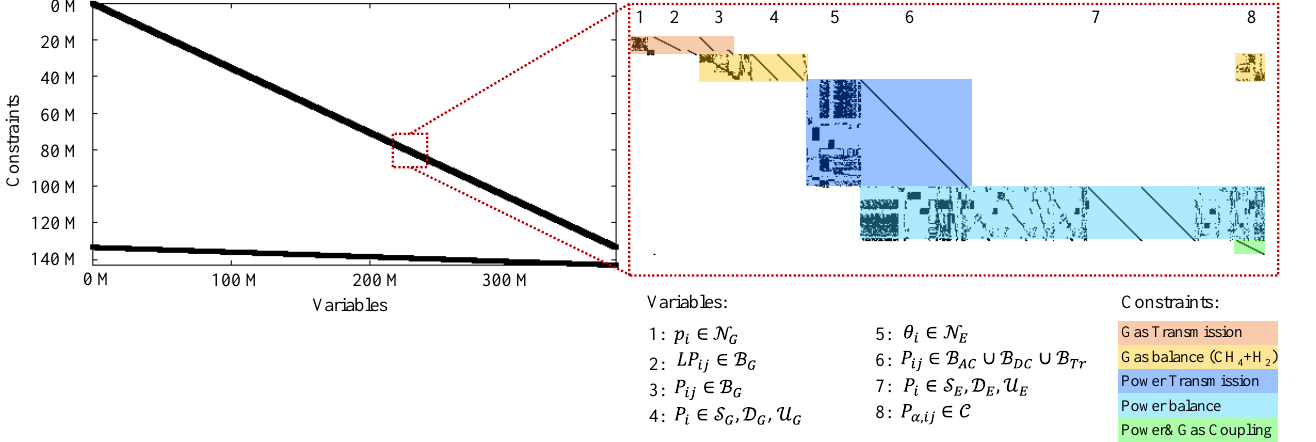
Figure 1. Structure of coefficient matrix (model input).